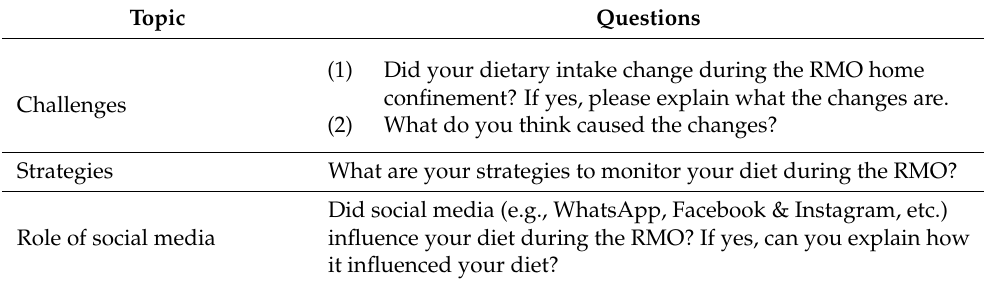
Table 1. Interview questions